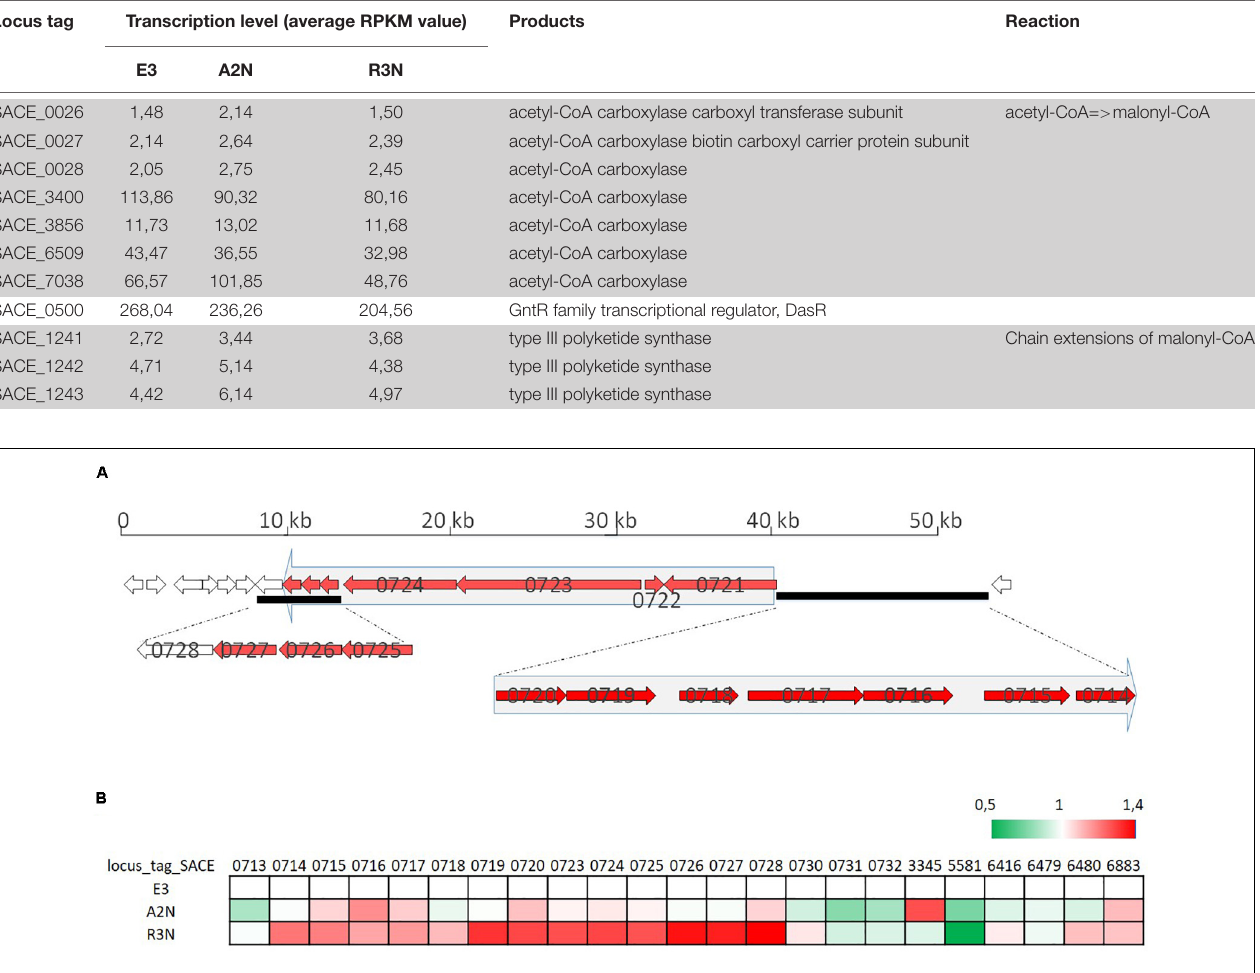
FIGURE 8 | Organization of the erythromycin biosynthesis gene cluster (A) and its transcription profiles (B) . Small arrows in (A) indicate coding regions of the erythromycin biosynthesis gene cluster and numbers on arrows are gene locus tags. Two big arrows in light gray consisting of several genes in red indicate the genes are co-transcribed. (B) shows relative transcription of genes in the cluster for E3, A2N, and